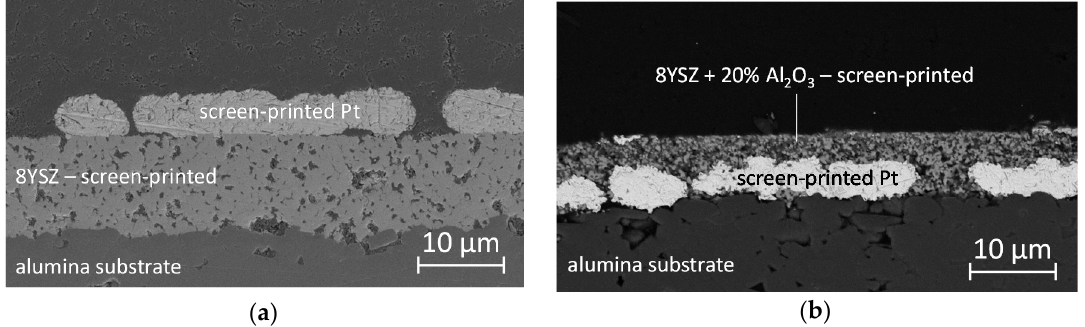
Figure 3. Cross-sectional SEM images of two sensor setups for the pulsed polarization technique using porous electrolytes produced by screen-printing on alumina substrates: ( a ) two times screen-printed 8YSZ films with overlying platinum electrode (SP 1); and ( b ) an electrolyte consisting of 8YSZ with incorporated Al 2 O 3 (20 weight %) on a buried platinum electrode (SP 8).